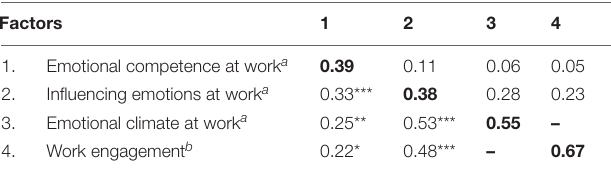
TABLE 6 | Correlations, average variance extracted (AVE), and estimated amount of shared variance between the dimensions of Emotional Agency, Emotional Climate at Work, and Work Engagement ( N =